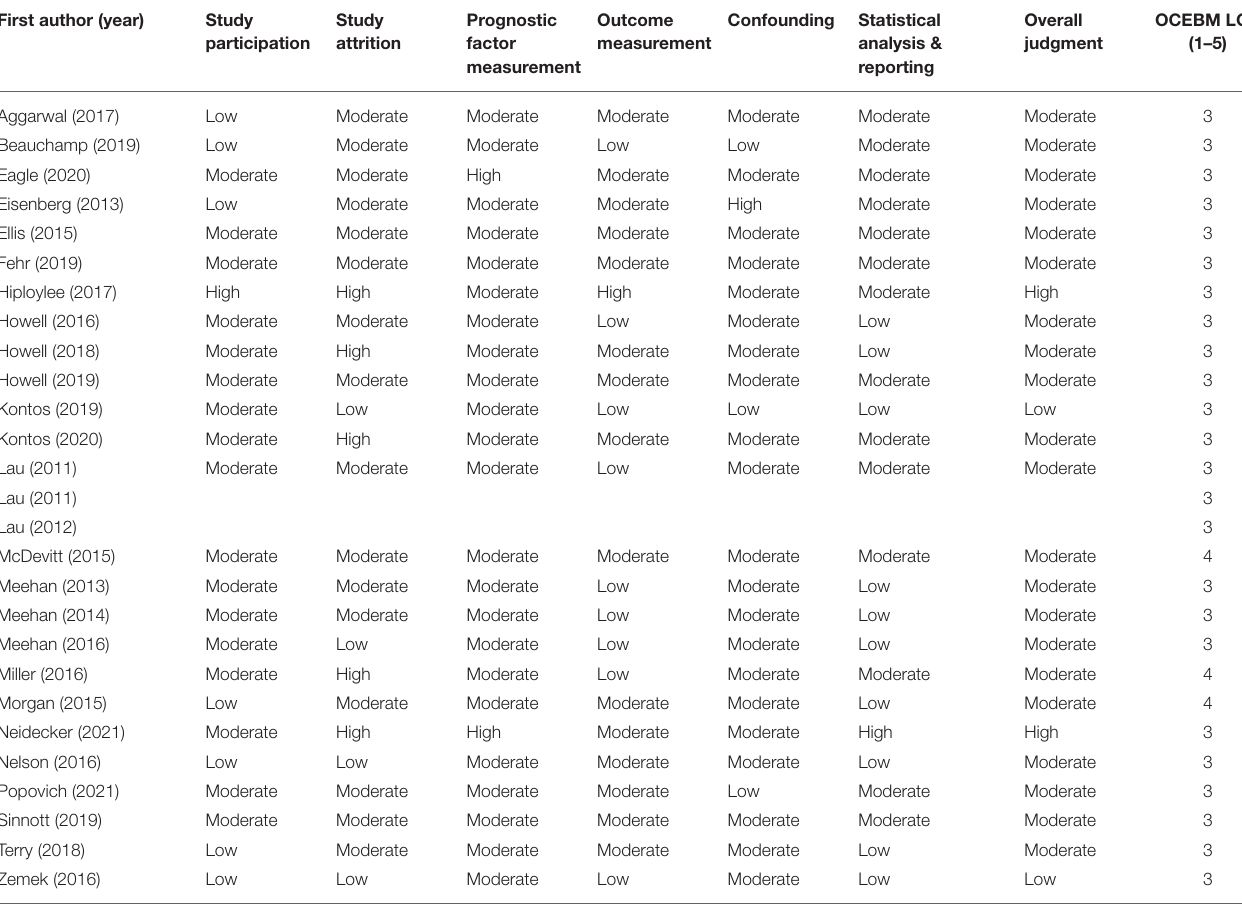
TABLE 3 | Risk of bias, as rated by the Quality in Prognostic Studies (QUIPS), and oxford centre for evidence-based medicine level of evidence.